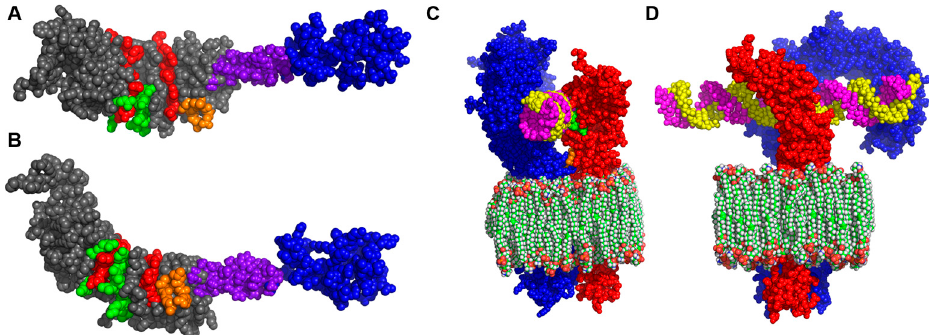
Figure 2. Bioinformatics modelling demonstrates shared functional homology of the extracellular domain of I329L with the ECD of TLR3. Models of I329L in a front ( A ) and side ( B ) view illustrate the structural features of the protein. The ectodomain is colored grey, the transmembrane region purple and the endodomain blue. The leucine rich repeats (LRRs) of the ectodomain are colored red. The aminoacids corresponding to the dsRNA interaction motif and the dimerization motif are colored green and orange, respectively. The I329L model was overlaid on one of the chains of the TLR3 dimer model (PDB: 3CIY) (to visualize the possible regions of interaction to form a heterodimer), shown in front ( C ) and side ( D ) view. In the dimer models, I329L is colored red, TLR3 blue and dsRNA yellow and pink.